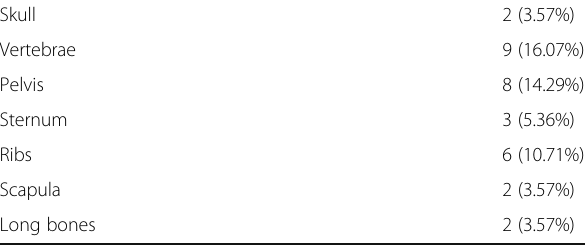
Table 8 Distribution of sites of skeletal metastases, n (%)* Skull 2 (3.57%) Vertebrae 9 (16.07%)